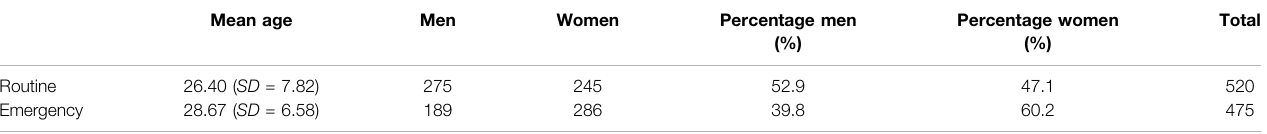
TABLE 1 | Participants ’ data.